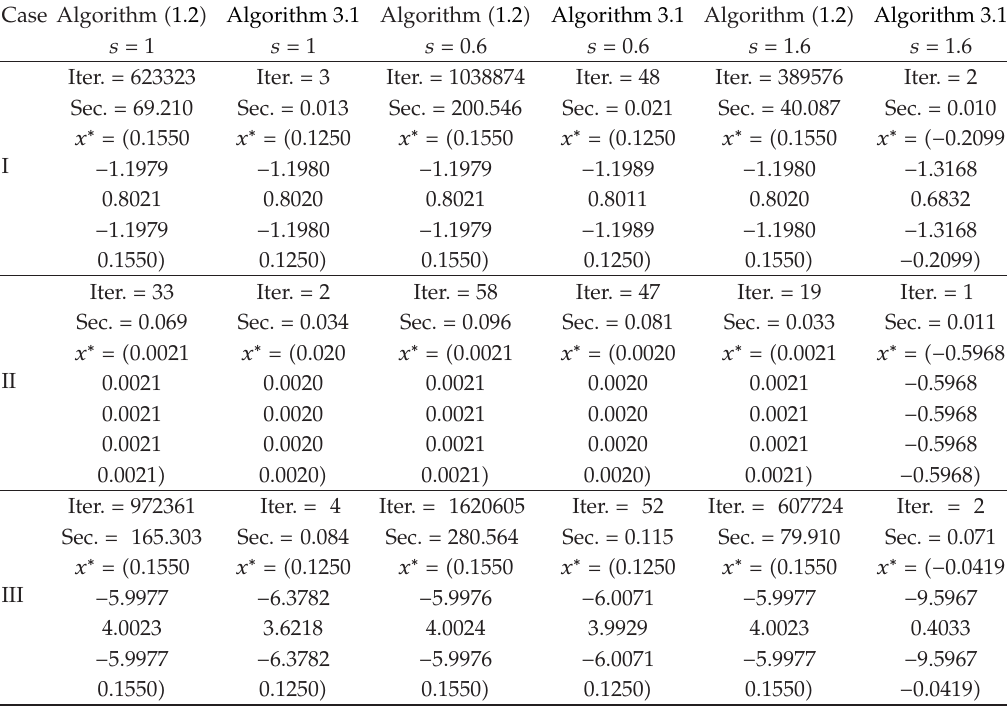
Table 3: The numerical results of Example